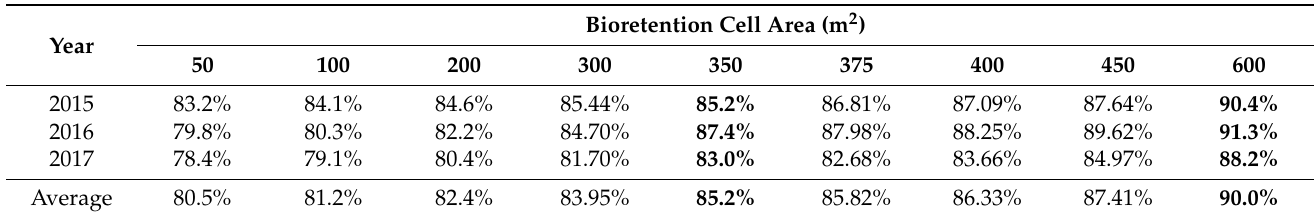
Table 3. The achievement rate of TP under different areas of bioretention cells placed within the watershed.